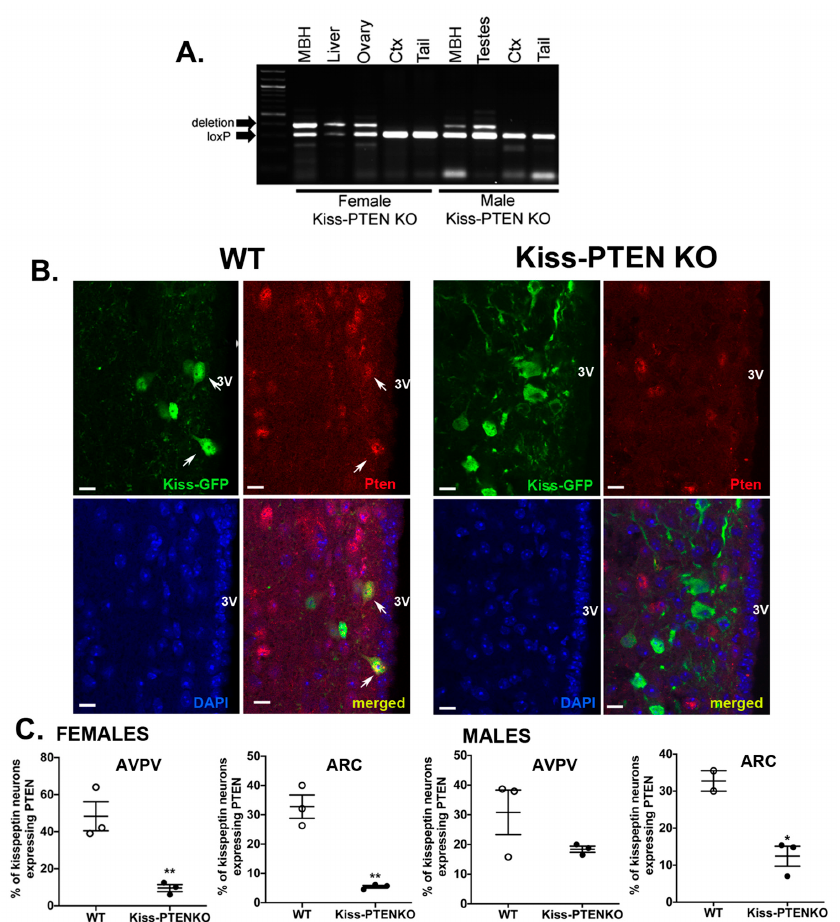
Figure 1. Phosphatase and tensin homolog (PTEN) deletion is restricted to kisspeptin-expressing tissues and neurons in Kiss-PTEN KO mice. ( A ) Representative PCR analyses showing deletion of Pten exon 5 (404 bp product) in the mediobasal hypothalamus (MBH), liver, and gonads, whereas no deletion is observed in the cortex (Ctx) or tail (floxed 335 bp band only). Genomic DNA was isolated from indicated tissues from female and male Kiss-PTEN KO (Kiss-Cre + / PTEN flx / flx ) mice. ( B ) Representative images of double-immunofluorescent labeling of PTEN and GFP in Kiss-PTEN KO / R26-YFP mice show that the loss of PTEN expression is restricted to Kiss-YFP + neurons. White arrows indicate double-labeled kisspeptin neurons. Scale bar = 10 µ m. 3V, third ventricle. ( C ) The percentage of Kiss-YFP + cells co-expressing PTEN in both the anteroventral periventricular nucleus (AVPV) and arcuate nucleus (ARC) is lower in Kiss-PTENKO / R26-YFP animals ( n = 2–3 / genotype and sex). Values are means ± SEM. * p < 0.05, ** p <